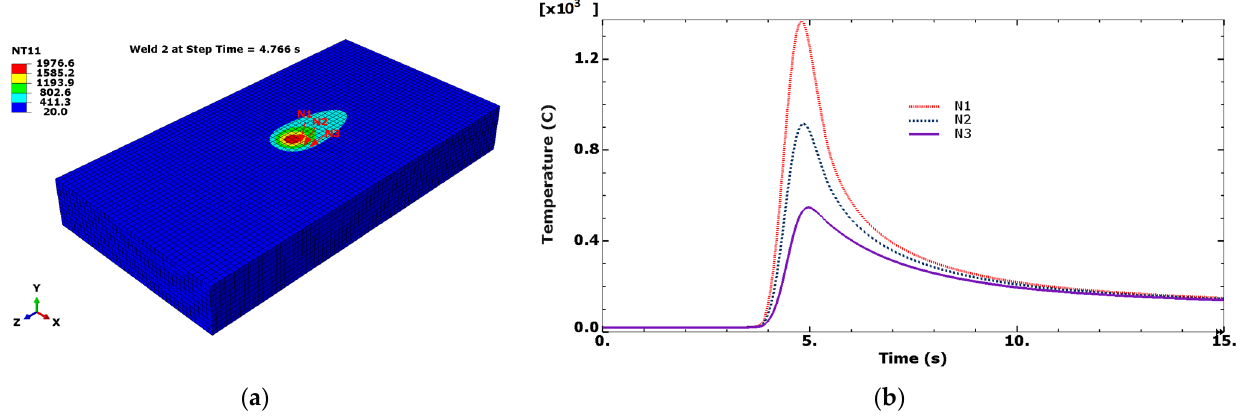
Figure 4. ( a ) An autogenous laser weld performed in a macro mesh of 40 × 10 × 75 mm and ( b ) thermal cycles at documented N1, N2 and N3 locations. Element size 1 mm.